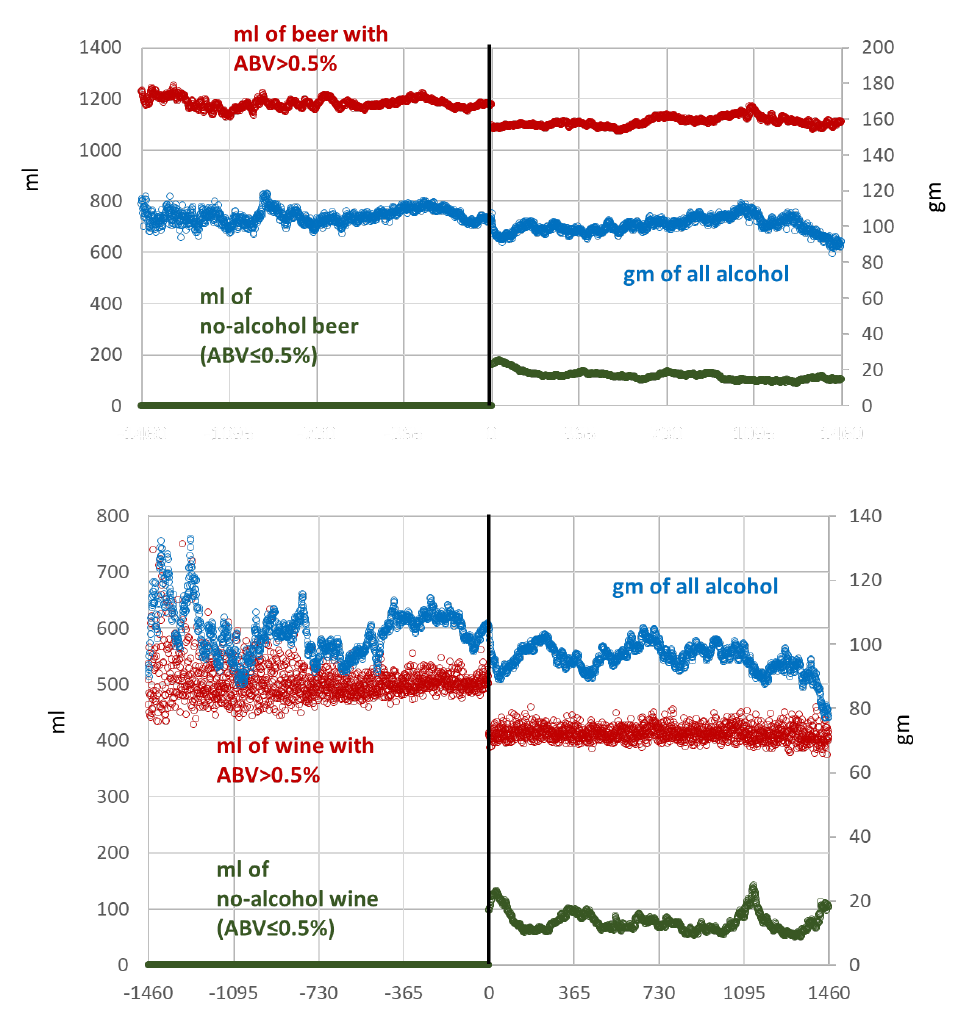
Figure 1. Households that had bought at least one no-alcohol beer and at least one other-strength beer ( Top graph ), with the first purchase of no-alcohol beer >3 months after the first purchase of other-strength beer (new purchasers of no-alcohol beer) ( n = 4115 households). Households that had bought at least one no-alcohol wine and at least one other-strength wine ( bottom graph ), with the first purchase of no-alcohol wine >3 months after the first purchase of other-strength wine (new purchasers of no-alcohol wine) ( n = 1271 households). Left axis : mL purchased per adult per household per day of purchase per study day; right axis : grams of all alcohol purchased per adult per household per day of purchase per study day; vertical line : first household purchase of no-alcohol beer or wine; data points : daily, with exponential smoothing. The associated reduction in purchased grams of alcohol was greater amongst younger than older households but showed no clear pattern according to social grade (Table 2). With respect to the variable of autonomous community, associated reductions in purchased grams of alcohol were greater when higher volumes of beer were purchased prior to the event (Table 2). The standardized regression coefficient of the associated reduction with the initial volume of beer purchased prior to the event was − 0.735 (95% CI = − 0.960 to − 0.313). Hypothesis 2 (H2) . purchases of no-alcohol wines substituted for the purchase of higher-strength wines, leading to fewer grams of alcohol purchased